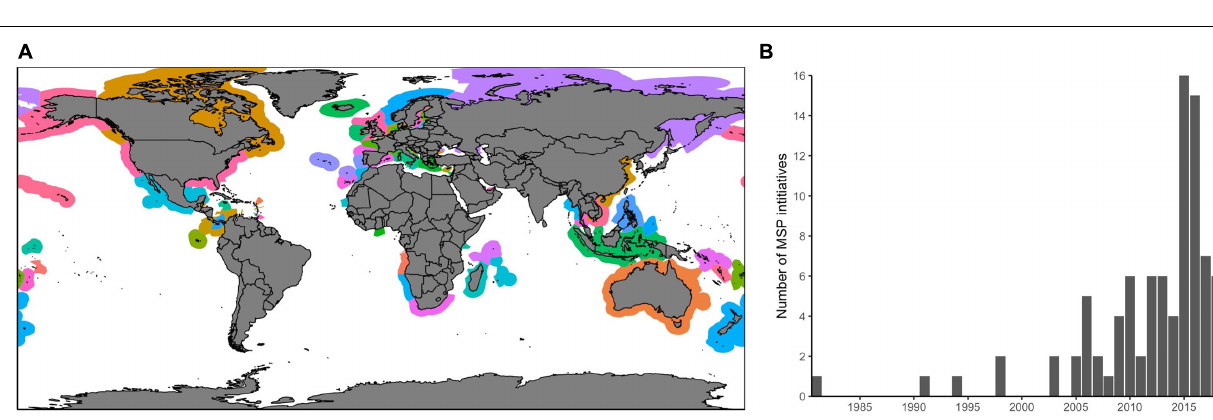
FIGURE 1 | A schematic representation of the Marine spatial planning implementation process. The missing layers must be addressed in all steps.